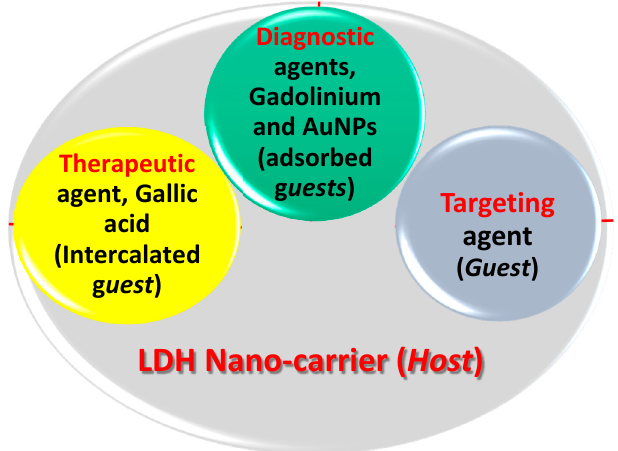
Figure 1. Schematic arrangement of GAGZAu nanocomposite in respect to theranostic delivery system in a typical host–guest relationship.